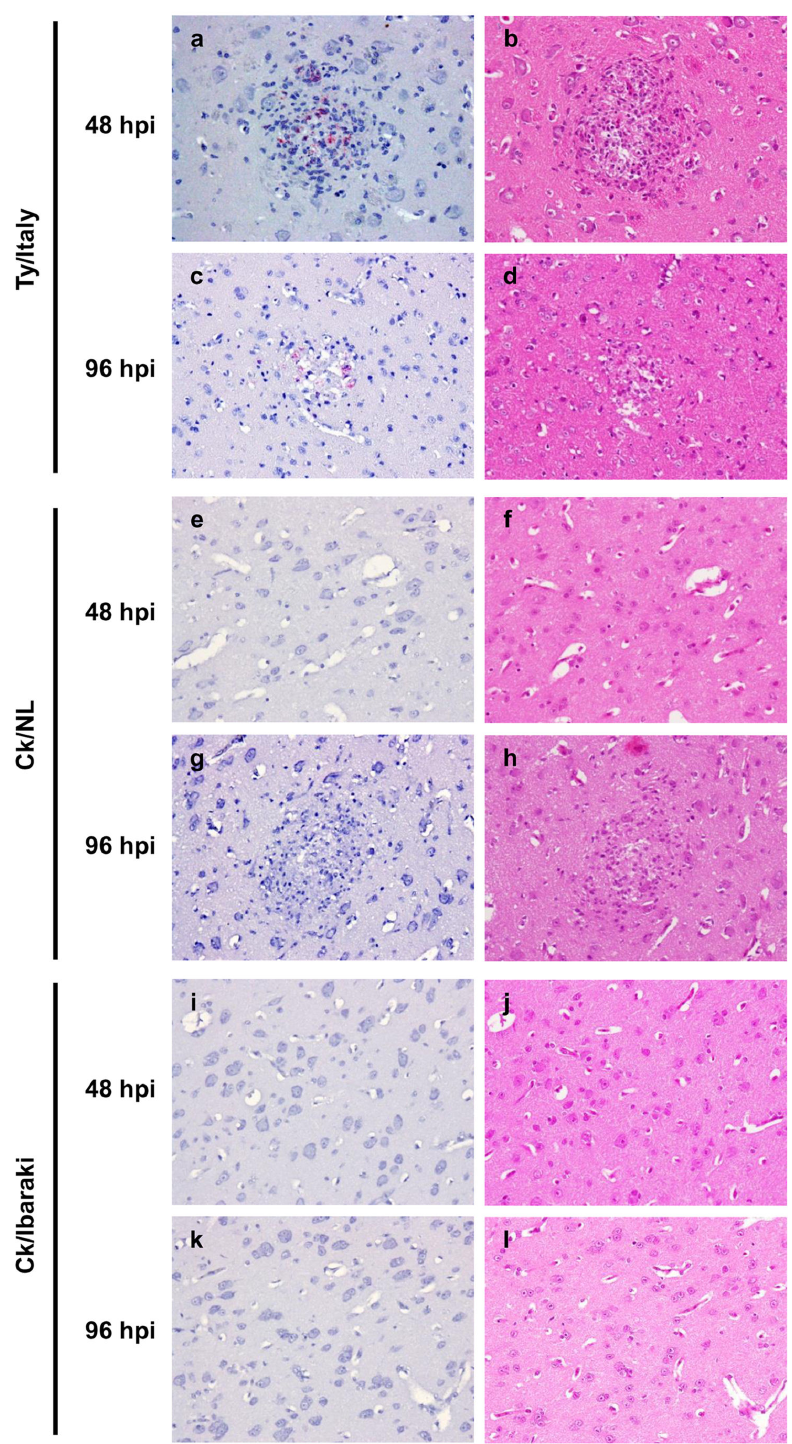
Figure 5. IL-6 mRNA in the brain detected using in situ hybridization. IL-6 mRNA expressing cells in the brains of the chickens infected with Ty/Italy was determined by in situ hybridization. IL-6 signals, represented as red color, were mainly localized to the microglial nodules on the section at 48 ( a ) and 96 hpi ( c ). The IL-6 mRNA was not detected in the brains of the Ck/NL-infected chickens ( e and g ), nor in those of the Ck/Ibaraki-infected chickens ( i and k ). The consecutive sections of HE staining ( b , d , f , h , j , l ) were examined by in situ hybridization ( a , c , e , g , i , k ), respectively. Original magnification, ×400. doi: 10.1371/journal.pone.0068375.g005 PLOS ONE |